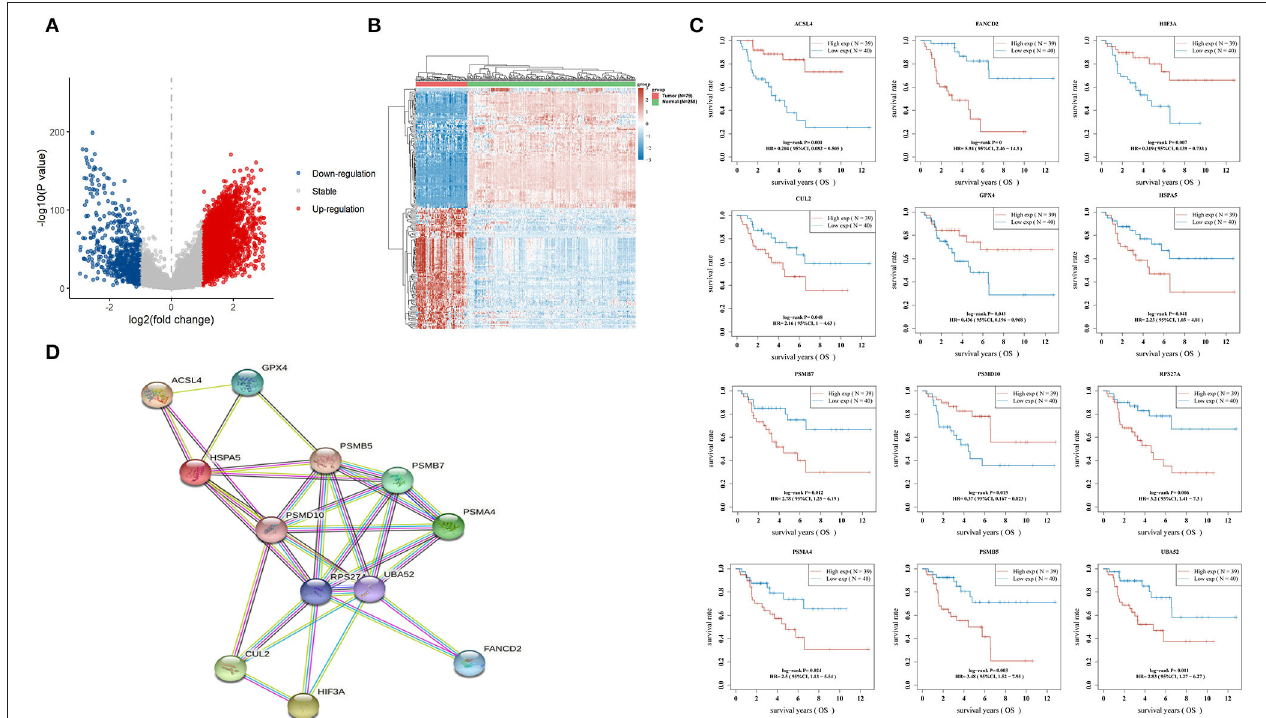
FIGURE 4 | Hypoxia- and ferroptosis-related key genes in ACC. (A) Volcano plots indicating up-expressed and down-expressed genes in ACC compared with normal tissues; (B) Hierarchical clustering analysis of genes between ACC and normal tissues; (C) 12 genes significantly correlated with OS time of patient with ACC; (D) A PPI network of 12 genes retrieved from String. ACC, adrenocortical carcinoma; OS, overall survival; PPI, protein-protein interaction; String: